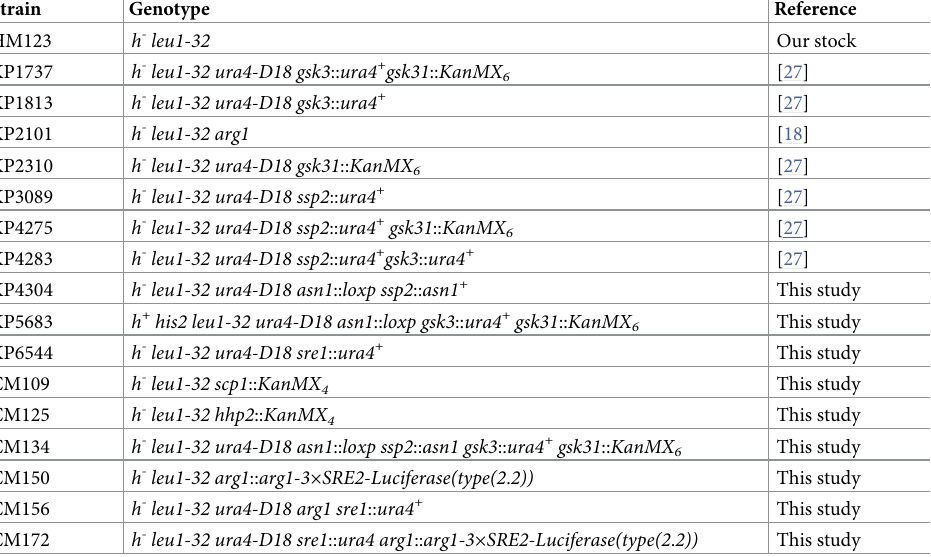
Table 1. Strains used in this